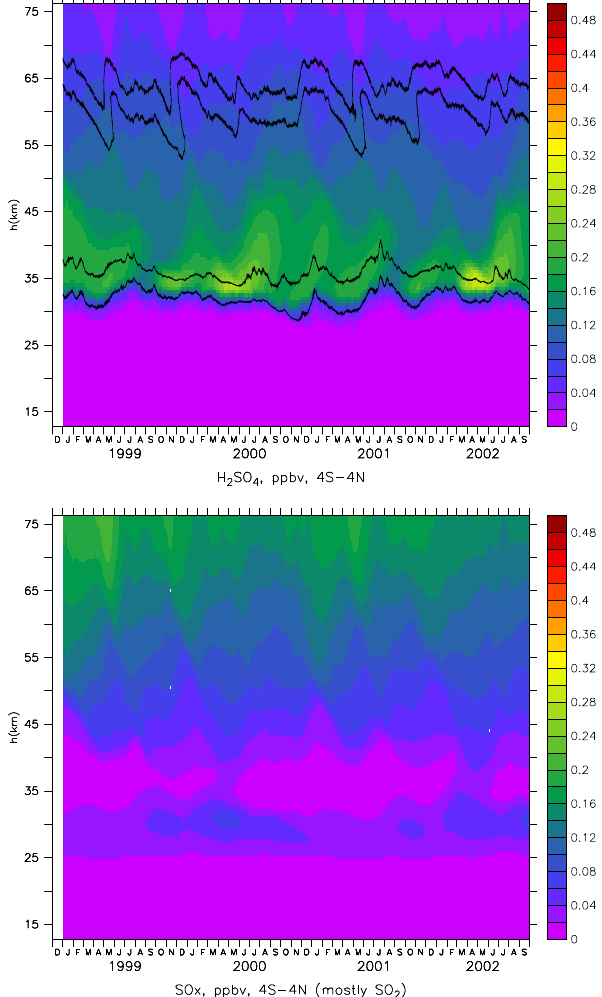
Fig. 6. Simulated gaseous H 2 SO 4 and SO x (mostly SO 2 ) in the tropics, ppbv. The contours in the upper panel show mean temper- atures of 230 and 240K, the region where sulphate aerosol evapo-